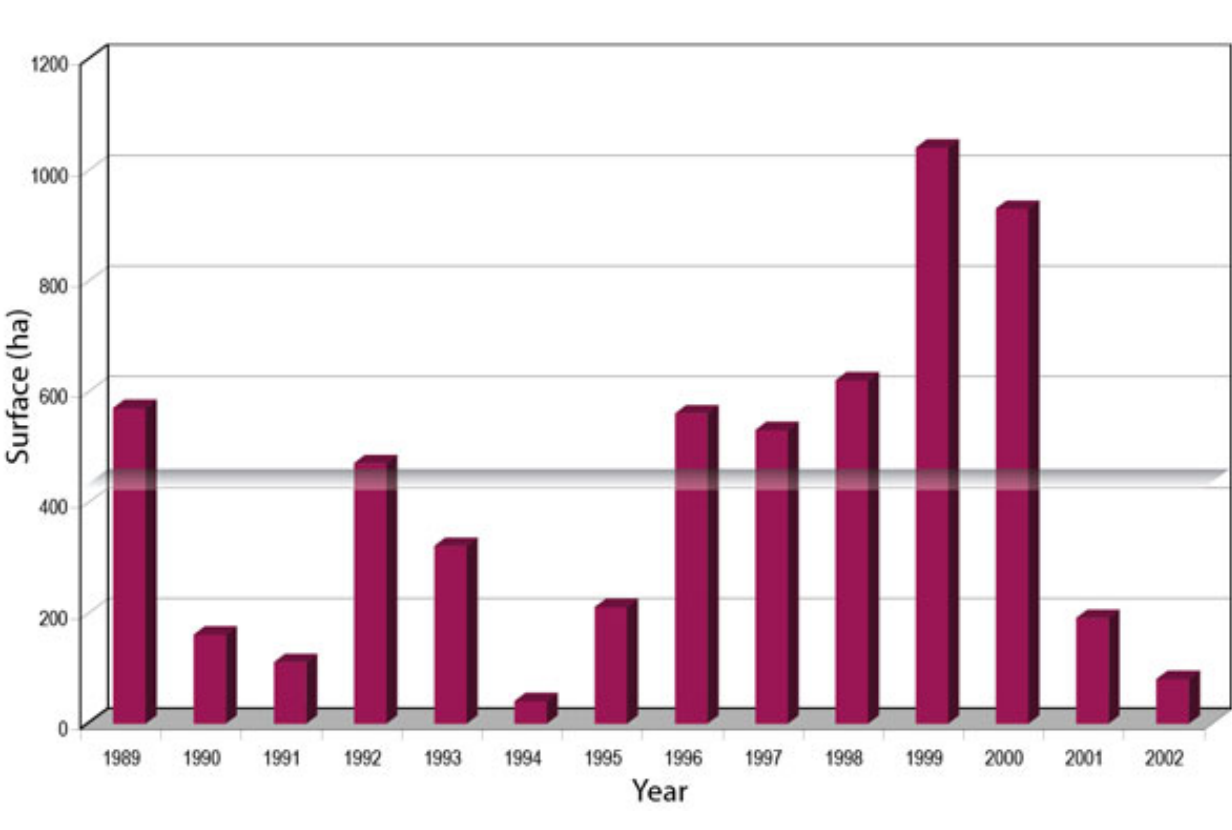
Fig. 3 . Annual variation in area of cultivated land in Tubu